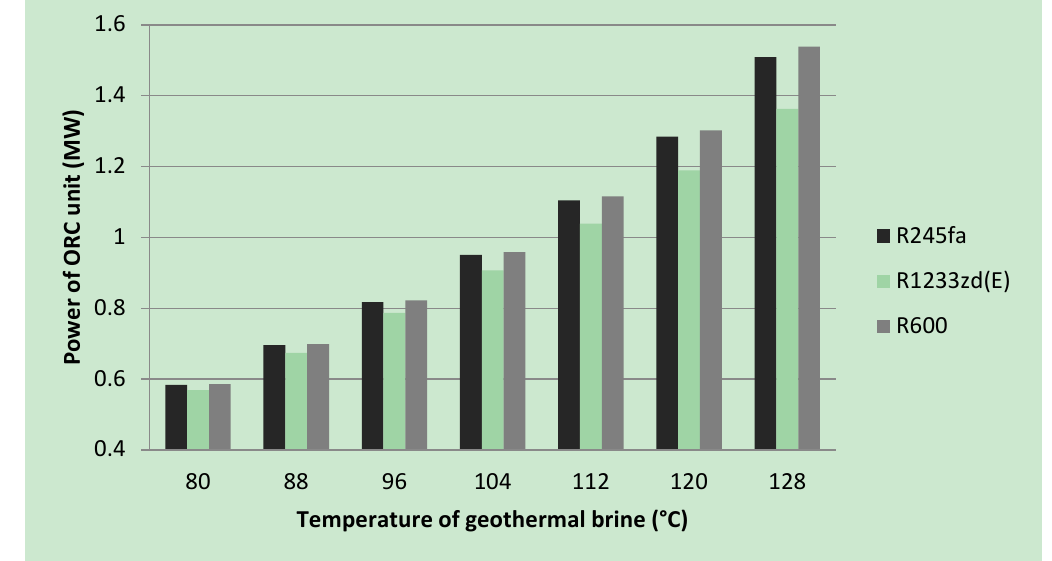
Figure 3. The power only from ORC unit in the modified ORC cycle (assisted by gas turbine) as a function of the geothermal brine temperature.